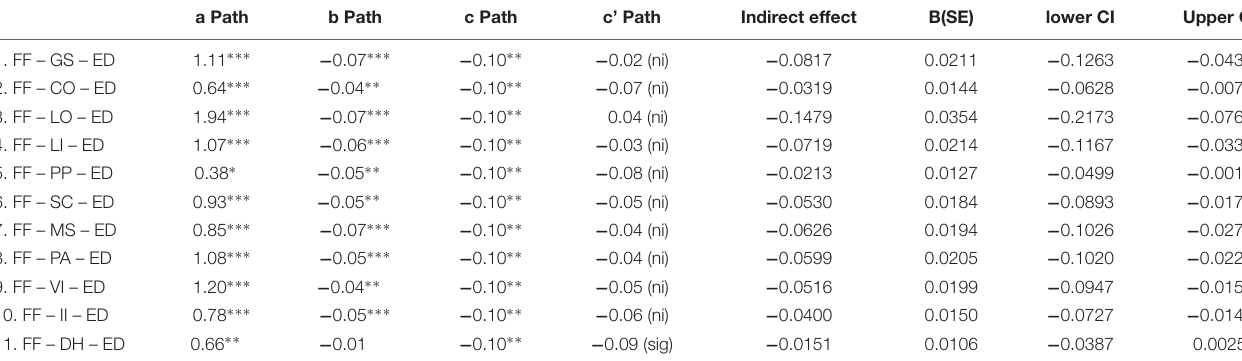
TABLE 3 | The role of global self-esteem and its dimensions in the relationship between FF and an increased risk for EDs. a Path b Path c Path c’